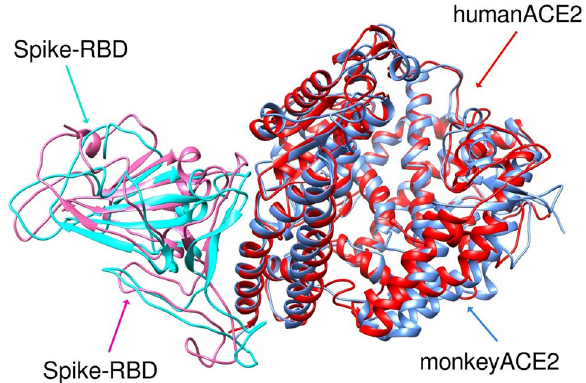
Figure 3. RMSD of overlay of S protein RBD (pink = monkey and turquoise = human) complex with human (red) or monkey (blue) ACE2 after MD simulations showing different geometry of the two